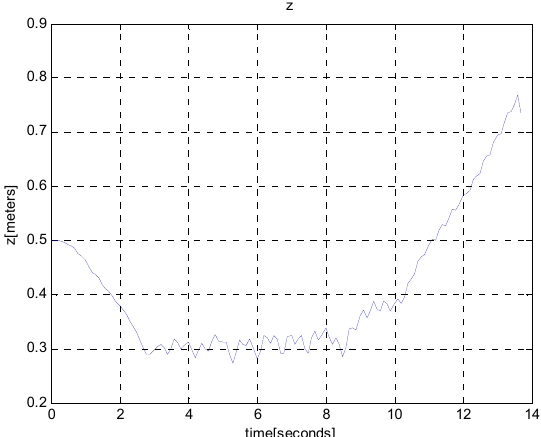
Figure 6. The depth of the vehicle with respect to time (controllers not considering fuel consumption).